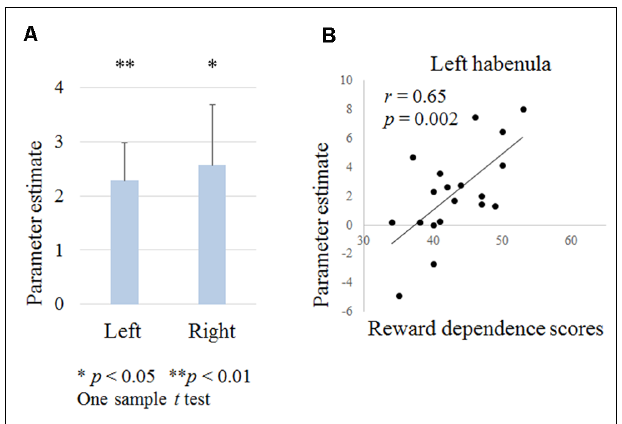
negative outcomes and temperament and character inventory (TCI) reward dependence